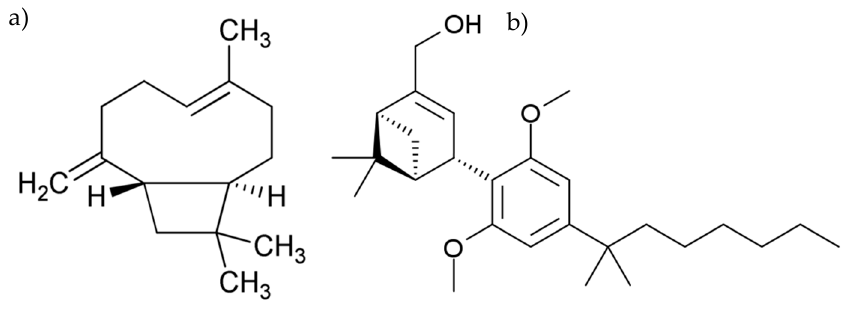
Figure 1. Chemical structures of ( a ) Beta-Caryophyllene and ( b ) HU308 .